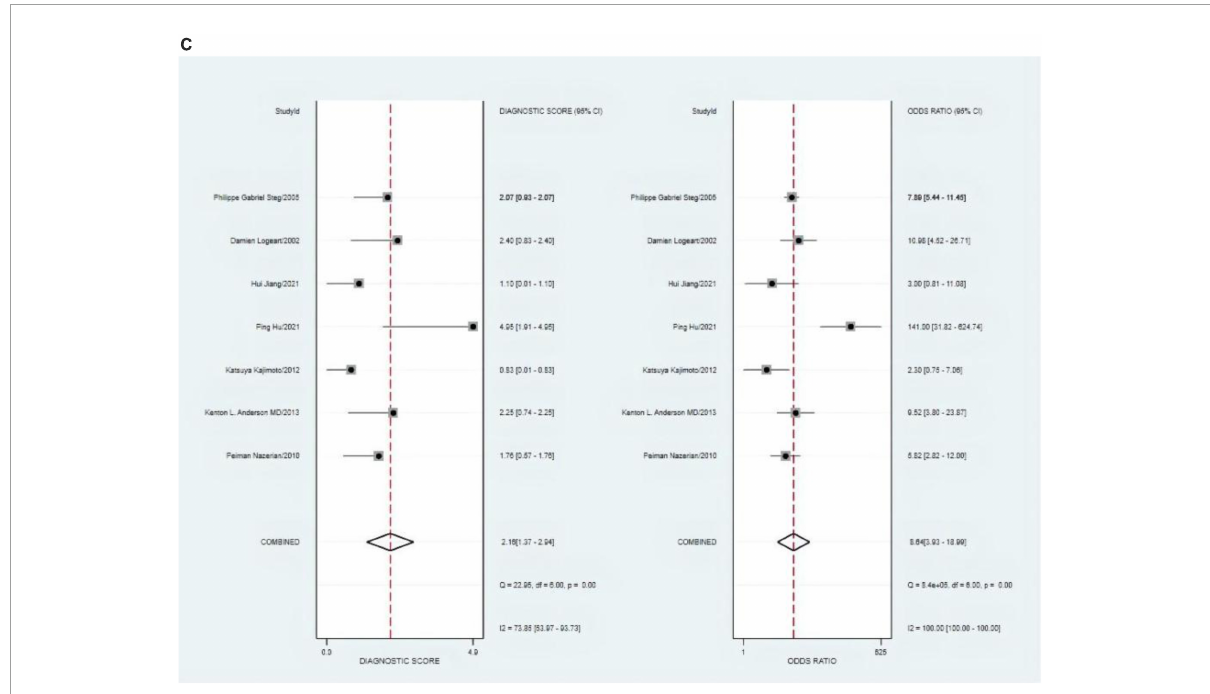
FIGURE8 (A) Forest plot of sensitivity and specificity of left ventricular ejection fraction (LVEF) in diagnosing heart failure (HF). (B) Forest plot of DLR positives and negatives of HF. (C) Forest plot of the diagnostic odds ratio (DOR) of LVEF in diagnosing HF.